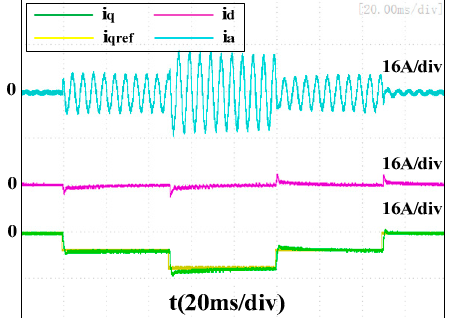
Figure 20. d-q axis current waveform of the current controller without decoupling at 12,000 rpm with Kp = 1000 π Ls.